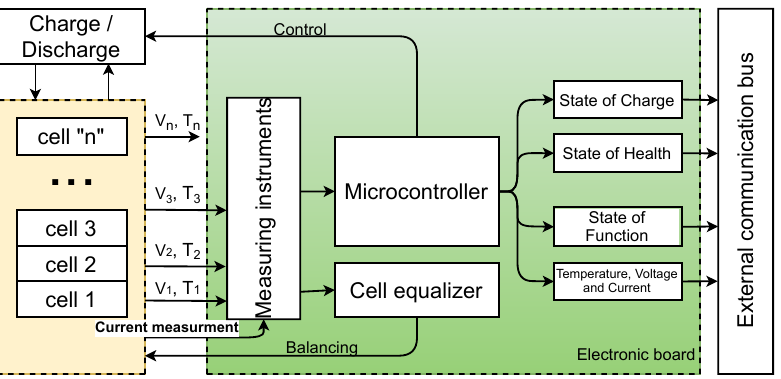
Figure 1. Simplified battery management system